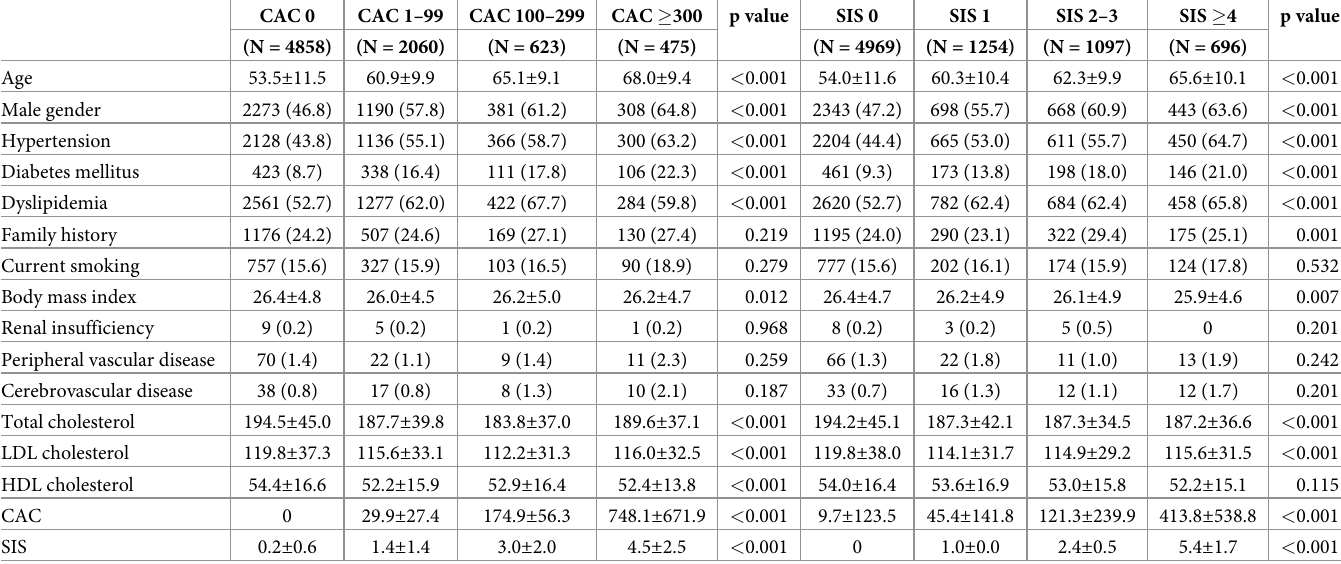
Table 2. Baseline characteristics by CAC or SIS categories.